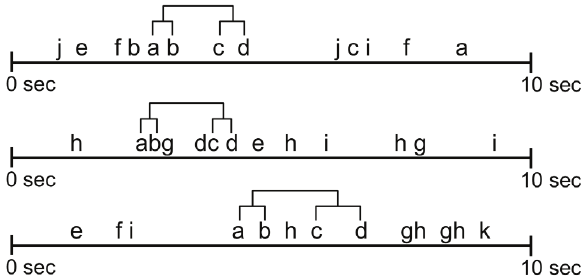
Figure 5. Three different 10-second stimulus viewings (letters represent fixations on regions a to k with successive fixations on the same region omitted) with T-pattern (abcd) occurring